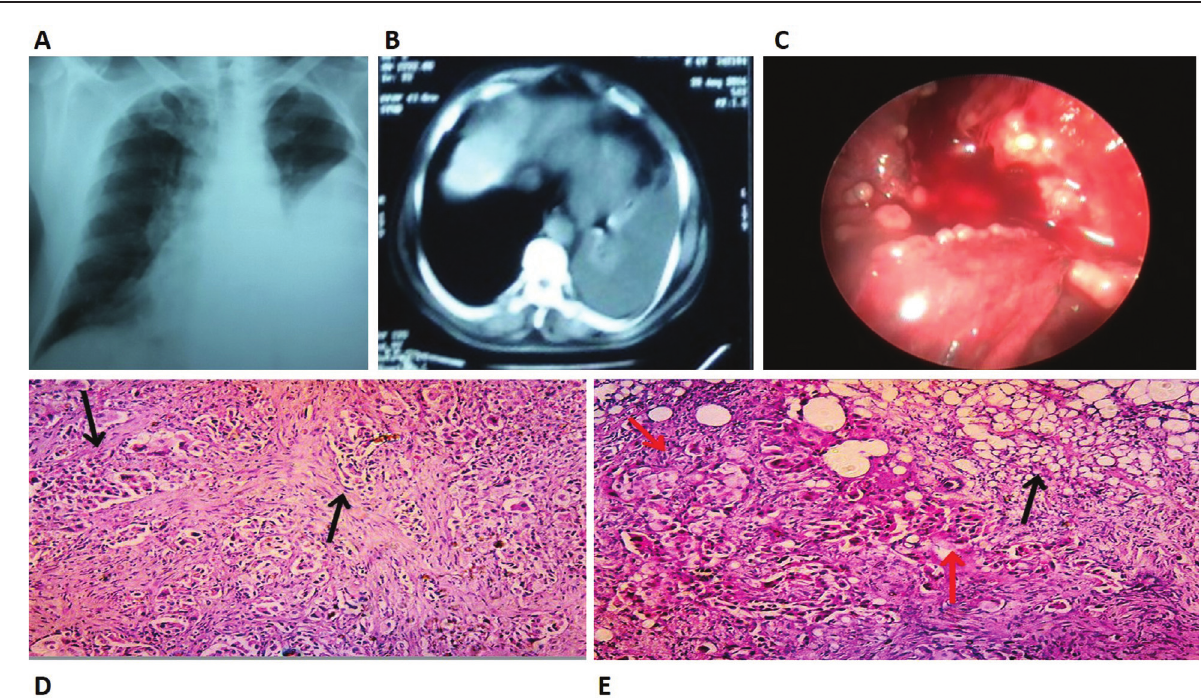
(a) Chest radiography showing left pleural effusion. (b) Computed tomography chest showing left pleural effusion. (c) Thoracoscopic image showing multiple nodules on costal and diaphragmatic pleura (d) Rigid forceps biopsy histopathology image (surface area 1.1×1.1 = 1.21 cm 2 ) showing sheets of malignant epithelioid cells consistent with mesothelioma (black arrows). (e) Cryoprobe biopsy histopathology image showing (surface area 0.9×0.9 = 0.81 cm 2 ) good biopsy depth evident by mesothelioma sheets of malignant epithelioid cells (red arrows) infiltrating too deep to the fat tissue (referred by black